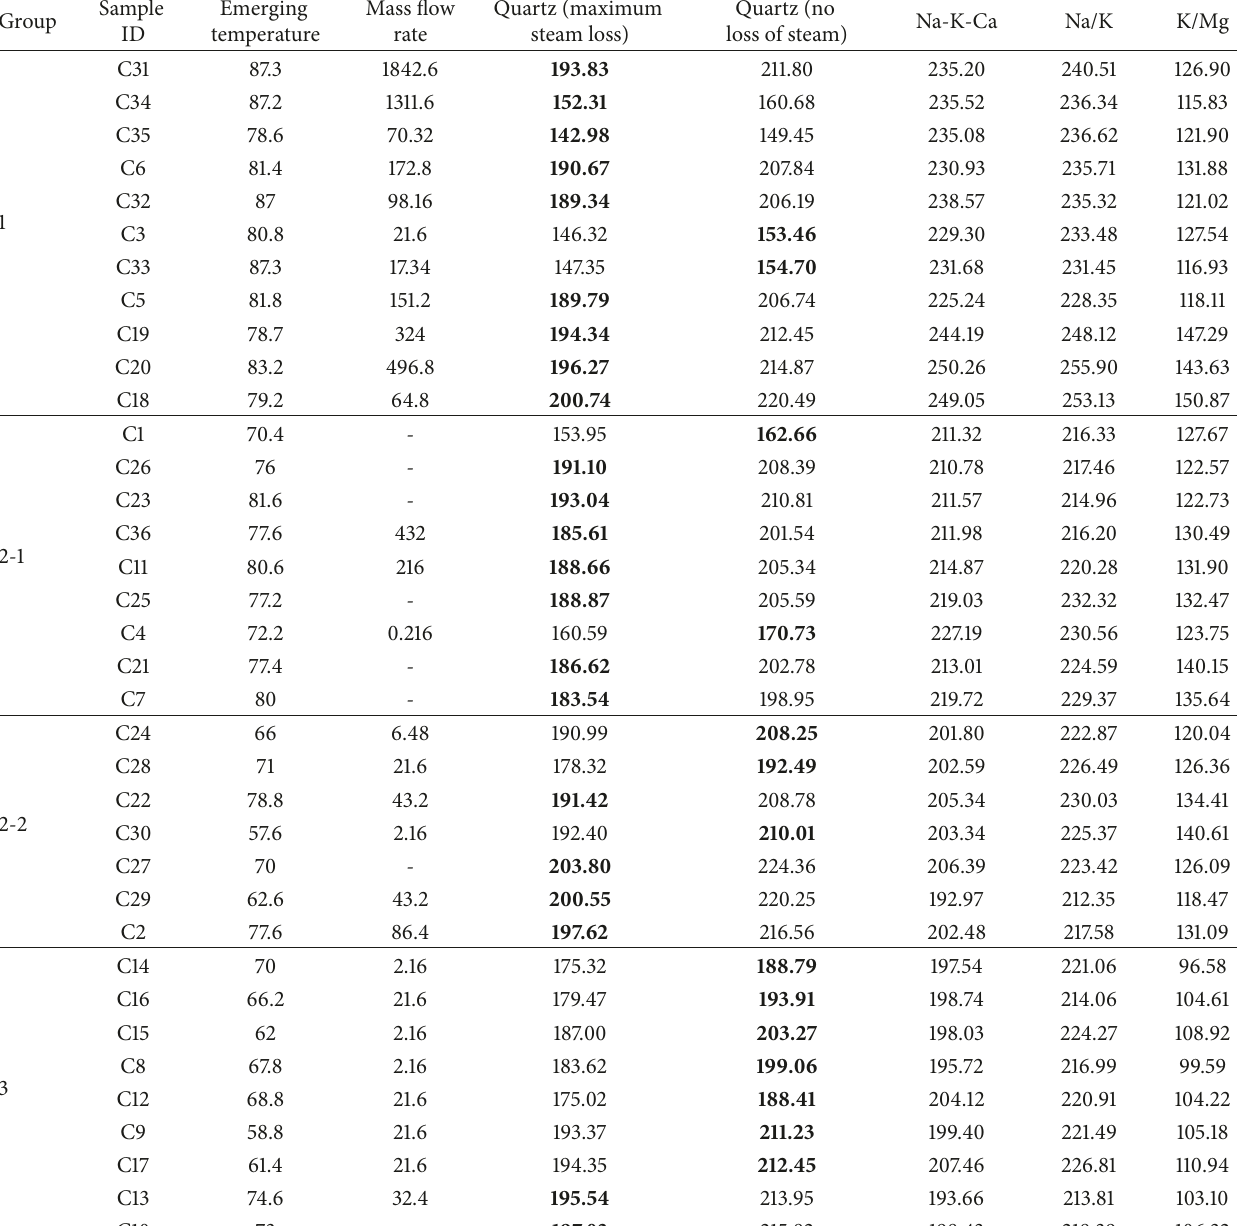
Table 3: Calculation results of geothermal reservoir temperatures in the research area ( 𝑇 in ∘ C, except for mass flow rate in L/min). The results in bold font are the optimum temperatures selected from the quartz geothermometers taking into account the measured emerging temperatures and the mass flow rates of the spring